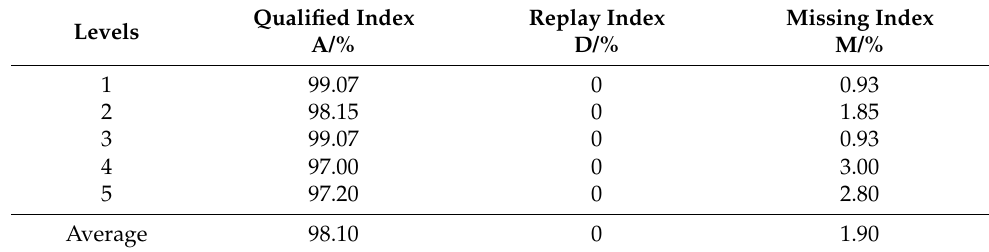
Table 4. Optimization parameter test